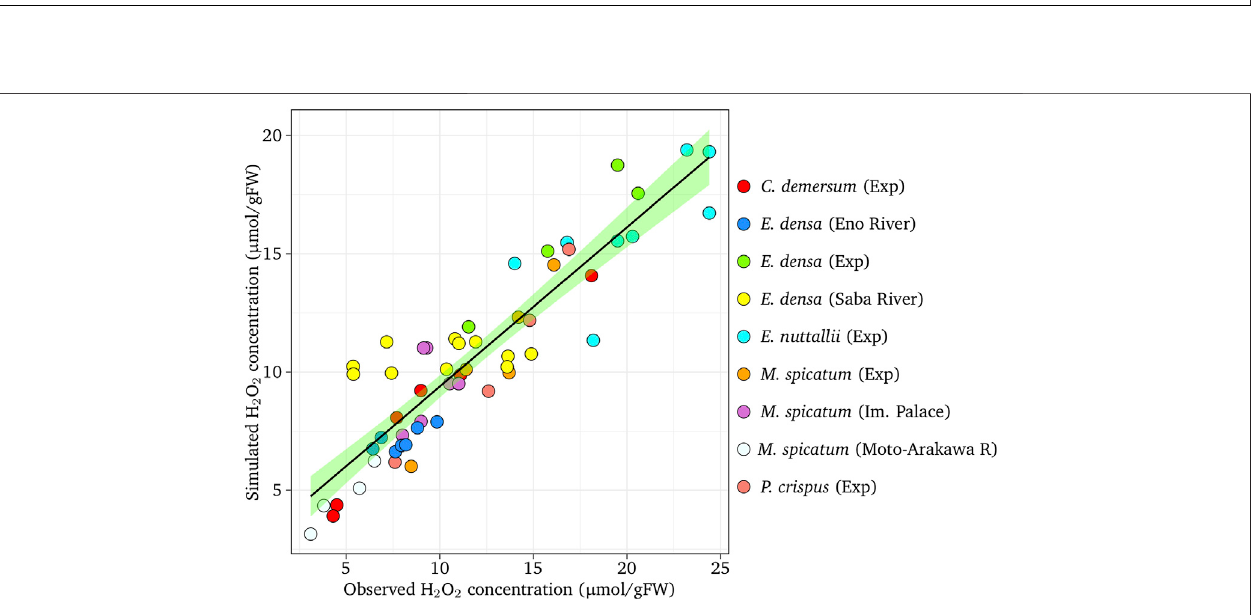
Frontiers in Environmental Science |